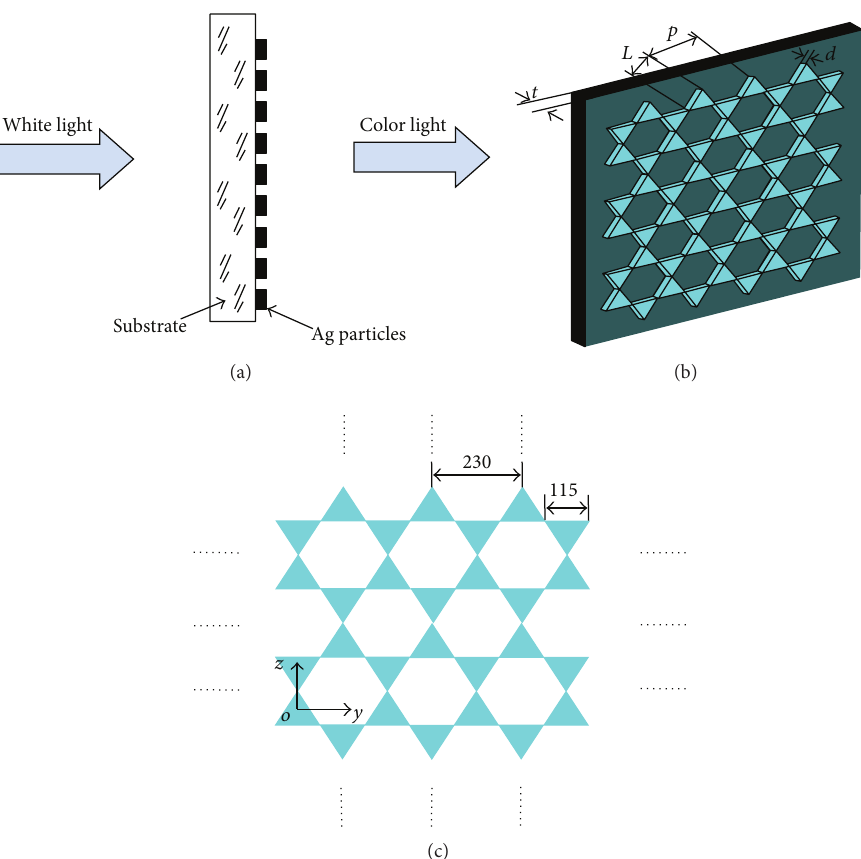
Figure 1: Schematic diagram of the plasmonic filter: (a) side view of the filter, (b) three-dimensional (3D) view of the filter, and (c) parameters of the DDA simulation.